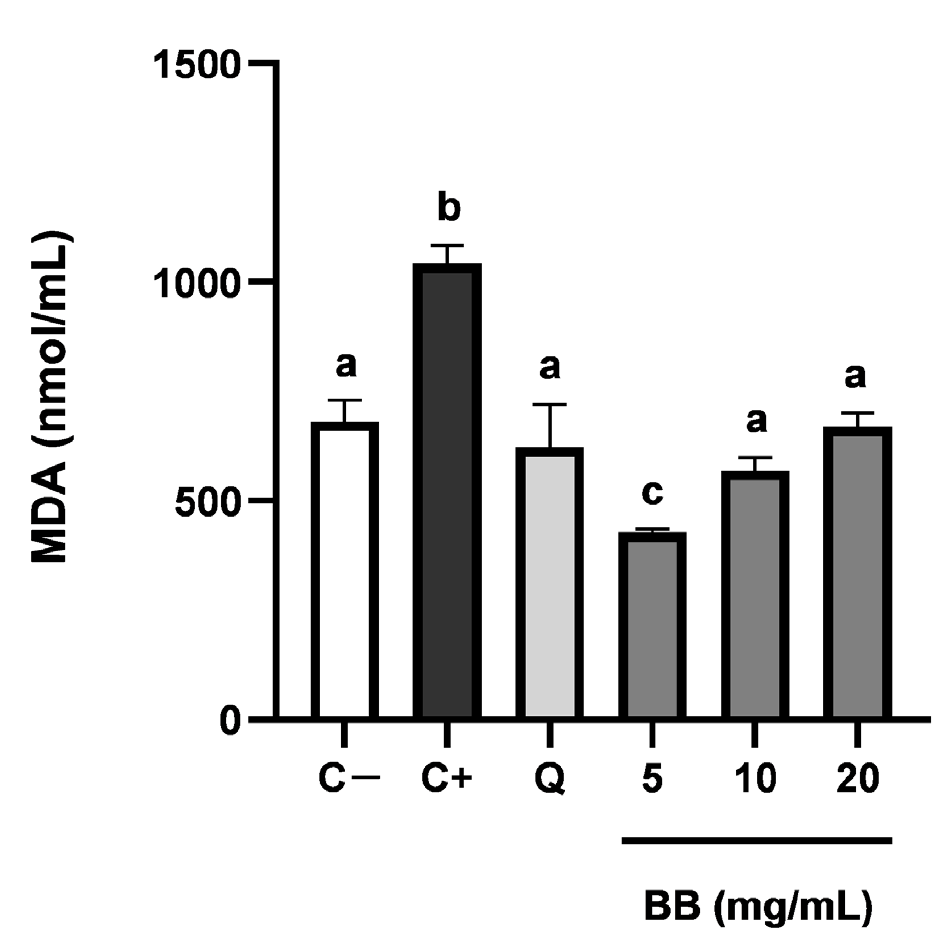
Figure 1. Inhibitory capacity of the blackberry extracts (BB) (5, 10 and 20 mg/mL) and quercetin 25 µ M (Q) of intracellular malondialdehyde (MDA) generation as a marker of lipid oxidation induced by TBH. C − are standard HUVEC cells. C+ are HUVEC cells in contact with TBH but without treatment. Results expressed as the average nmol MDA/mL ± SD (n = 6). Groups with different letters are significantly different ( p <